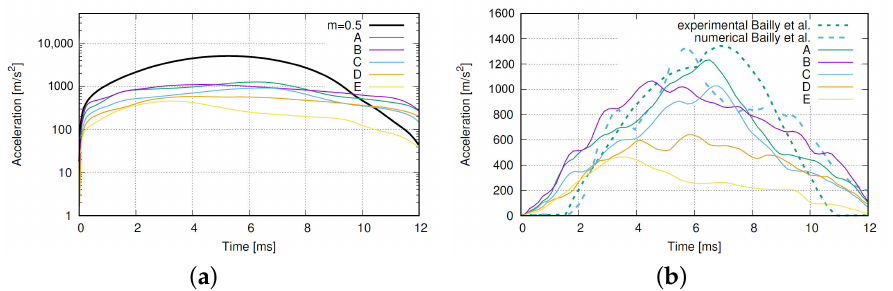
Figure 8. Acceleration in time for: ( a ) Constant parameters at m = 0.5 and softening at m = − 0.5 and ( b ) the expanded comparison of simulation and with literature results